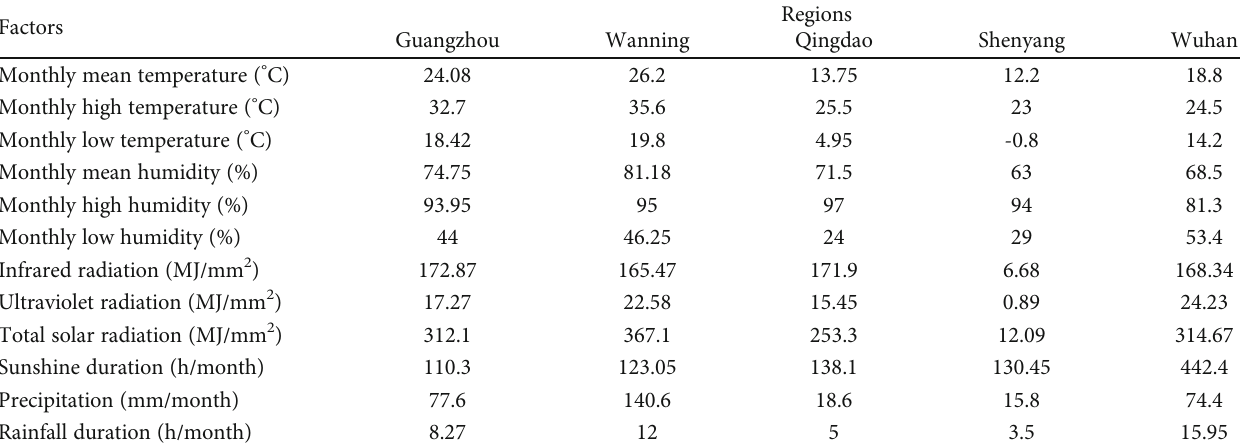
Table 4: Median values of the climatic factors in the well data-accumulated